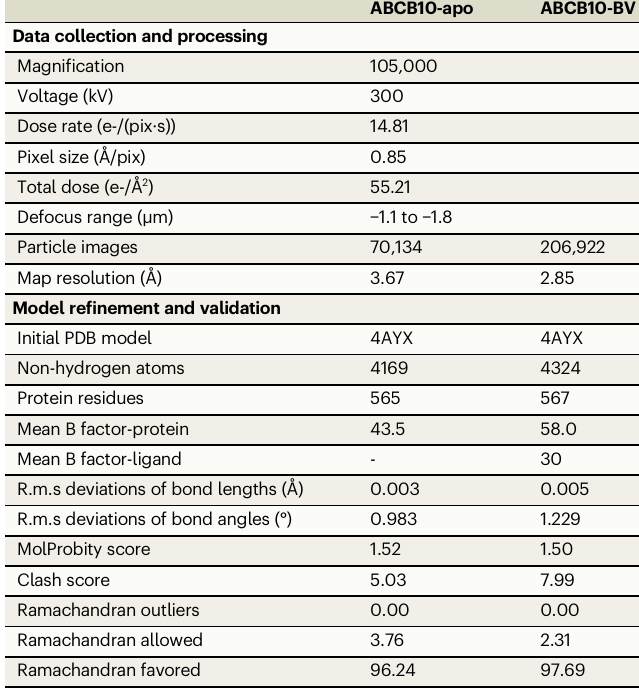
Table 1 | Cryo-EM data collection, re fi nement, and